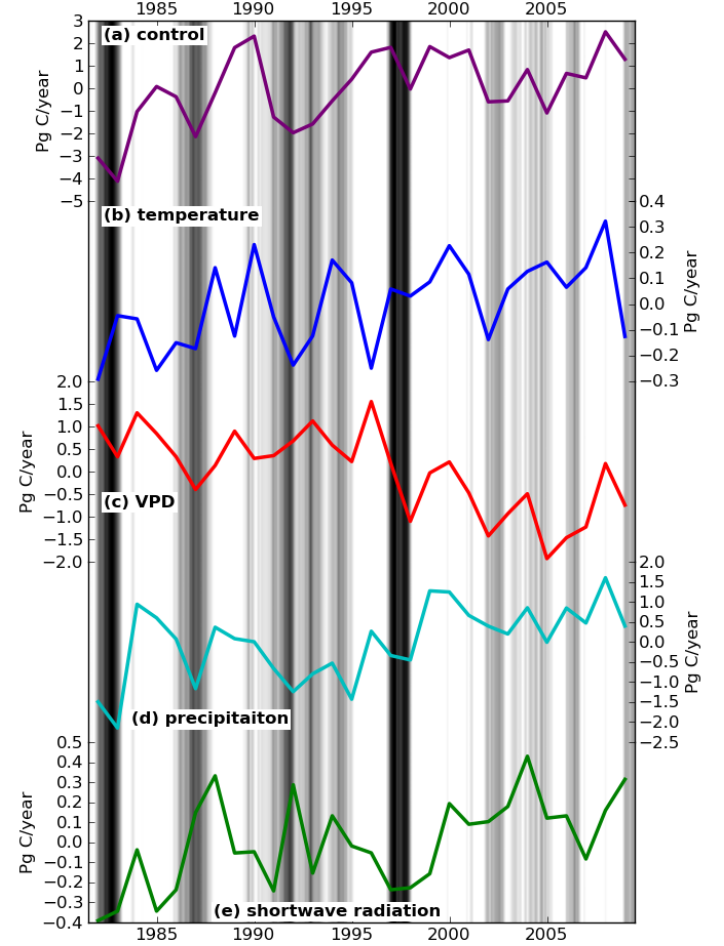
Figure 1. Sensitivity tests of global Gross Primary Production (GPP) to the individual climate variables for the period 1982 to 2009. Each anomaly in global GPP was simulated with ( a ) control run ( S_control ) and changing, ( b ) temperature ( S_temp ), ( c ) Vapor Pressure Deficit (VPD) ( S_vpd ), ( d ) precipitation ( S_precip ), or ( e ) shortwave radiation ( S_srad ). The vertical grey stripes indicate the timing of the Multivariate ENSO (El Niño–Southern Oscillation) Index (MEI) phases, with darker shades representing stronger El Niño phases.